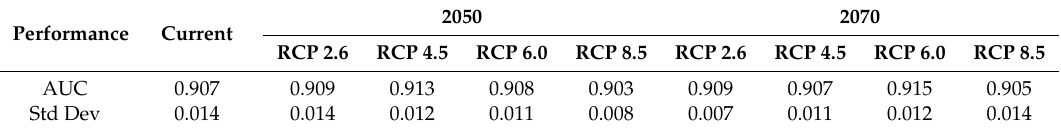
Table 1. Performance of MaxEnt models of T. ornatus in Amazonas